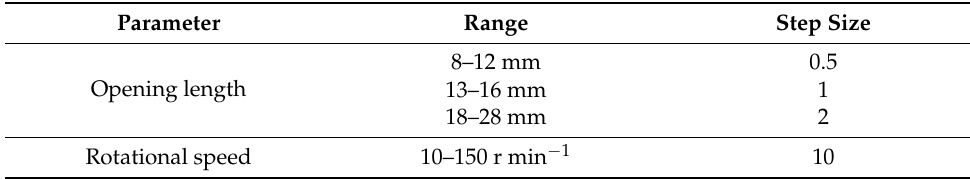
Table 1. Change ranges of regulation parameters.